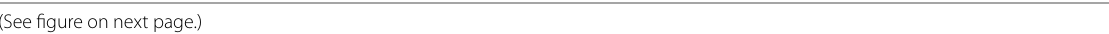
Fig. 2 LysMCre ± ::BDNF − / − (KO) have increased adiposity and impaired response to cold due to genetic denervation of scWAT. Adult (22–23 week old) male LysMCre − / − ::BDNF fl/fl (CON) and LysMCre ± ::BDNF −/− (KO) mice were cold exposed at 5 °C for 4 days; body weight and adiposity were compared between CON and KO groups, p 0.0750 and p 0.1107, respectively ( a ). Body and tissue weight data were analyzed by two‑tailed = = Student’s T ‑Test, N 5 CON, N 6 KO. Protein expression of PGP9.5 and tyrosine hydroxylase (TH) in inguinal scWAT was measured by Western = = blotting from adult (12–25 week old) 7‑day cold (5 °C) exposed WT/CON and KO male animals, p 0.0025 and p 0.0200, respectively ( b ). β‑Tubulin = = was used as a loading control for normalization. Data were analyzed by two‑tailed Student’s T ‑Test, N 3 WT/CON, N 4 KO, *denotes data that was = = removed from analysis due to lack of expression of loading control. Gene expression of Ucp1 was measured in adult (12–25 week old) 7‑day cold (5 °C) exposed WT/CON and KO males, p 0.0573 ( c ). Data were analyzed by two‑tailed Student’s T ‑Test, N 5 WT/CON, N 5 KO. Circulating thyroid = = = hormones, triiodothyronine (T3), and thyroxine (T4) were measured by ELISA from serum of adult (22–23 week old) 4‑day cold (5 °C) exposed CON and KO male mice, p 0.9526 and p 0.3471 , respectively ( d ). Data were analyzed by One‑way ANOVA, with Tukey’s multiple comparisons test, = = N 5 CON, N 6 KO. Immunofluorescent staining for UCP1 was performed on inguinal scWAT sections of adult (22–23 week old) male CON and = = KO mice following 4‑day cold (5 °C) exposure ( e ). Immunofluorescent staining for UCP1 and Perilipin was performed on inguinal scWAT sections of adult (22–23 week old) male KO mice following 4‑day cold (5 °C) exposure ( f ). Typogen Black, used to quench lipid autofluorescence, provided staining cell morphology which was visualized under brightfield microscopy. Overlay is immunofluorescence over brightfield of the same area ( f ). Images were acquired with a 10X or 40X objective and are representative of N 5 CON, N 8 KO (E) and N 4 KO ( f ). For all error bars = = =